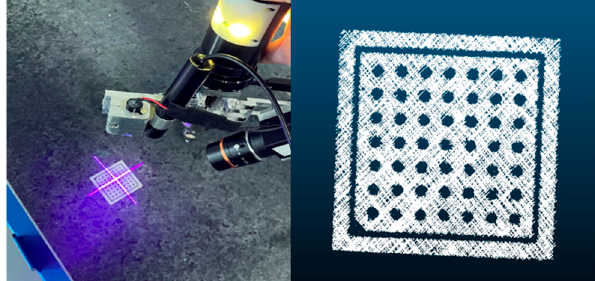
Figure 12. Calibration board scanning result.